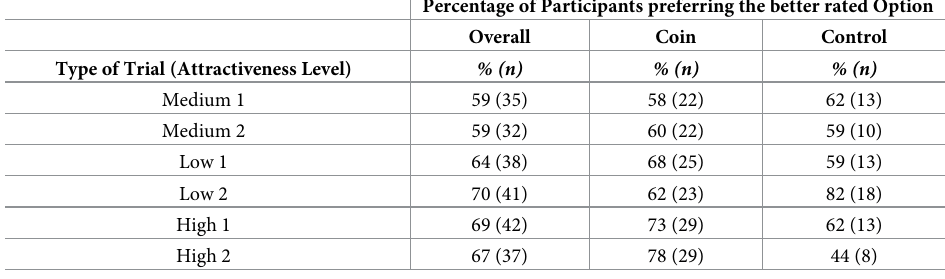
Table 6. Percentage of preference alignment in Study